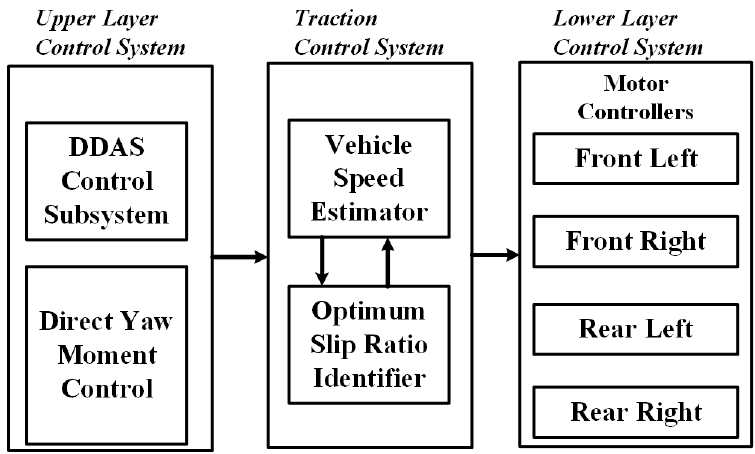
Figure 69. Independent torque control system proposed by Wang et al., Differential drive assisted steering (DDAS) subsystem and direct yaw moment control subsystem creates the upper layer. The traction control subsystem processes the inputs, and the controlling is done through the lower layer [178].